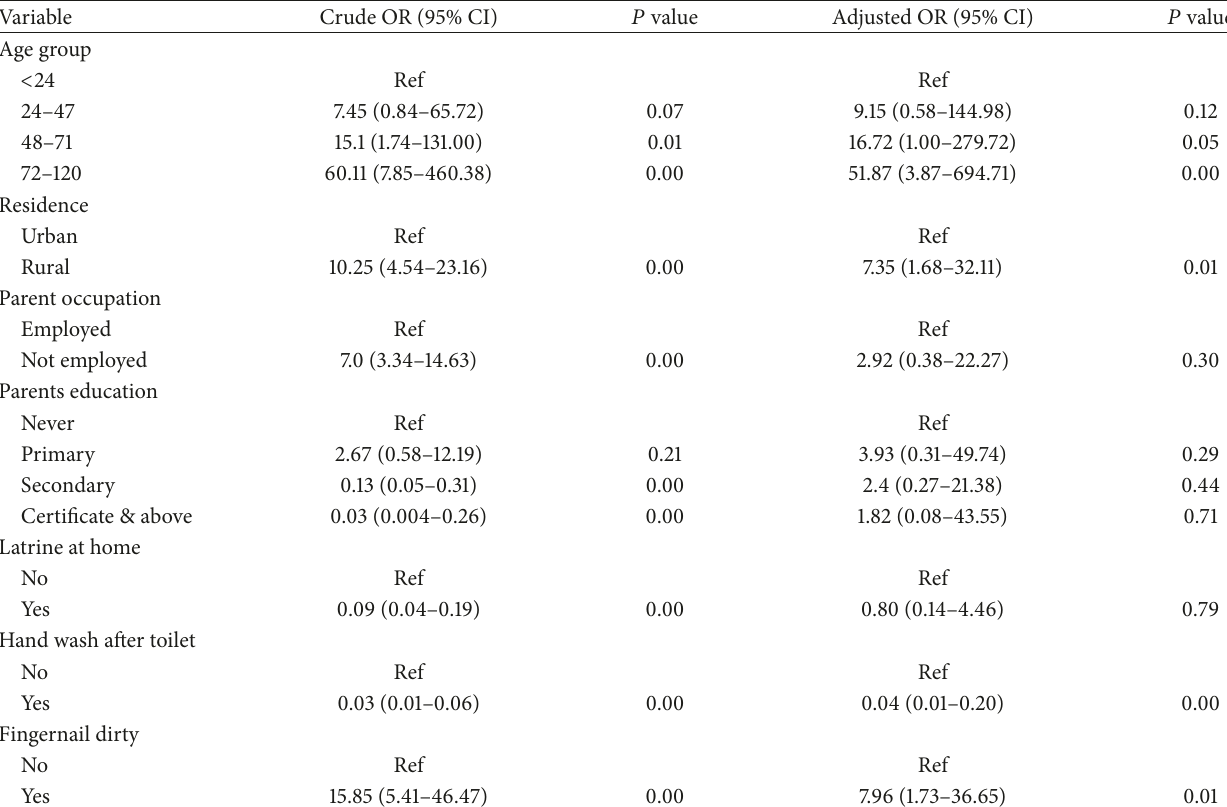
Table 3: Factors associated with helminths infestation in study